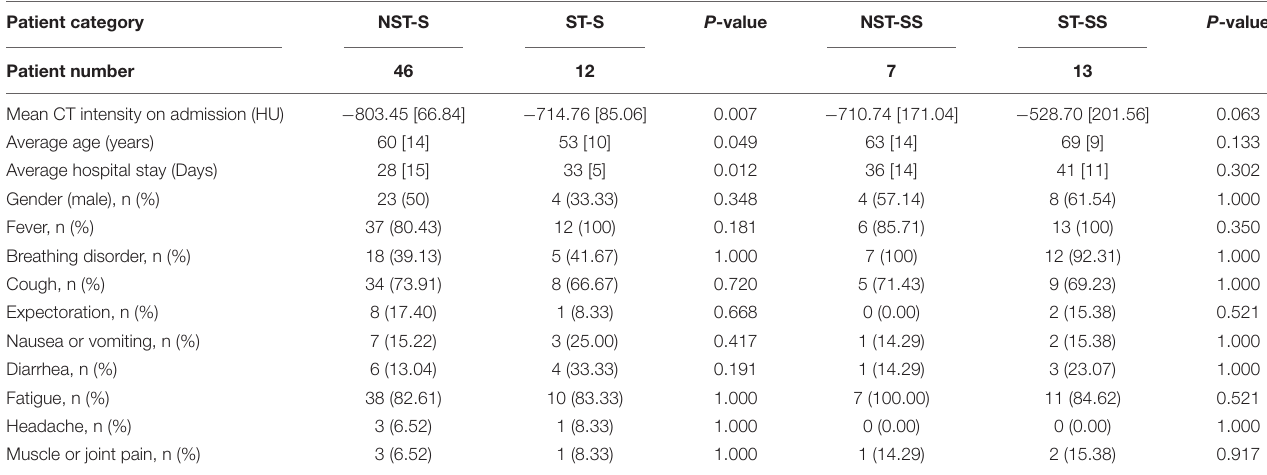
TABLE 1 | Clinical characteristics of all the